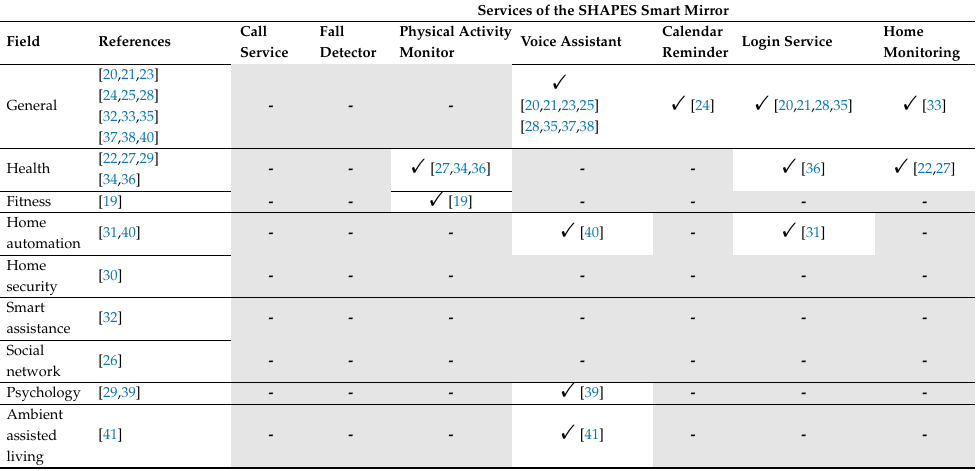
Table 2. Comparison between the services offered by previous related work and the SHAPES smart mirror